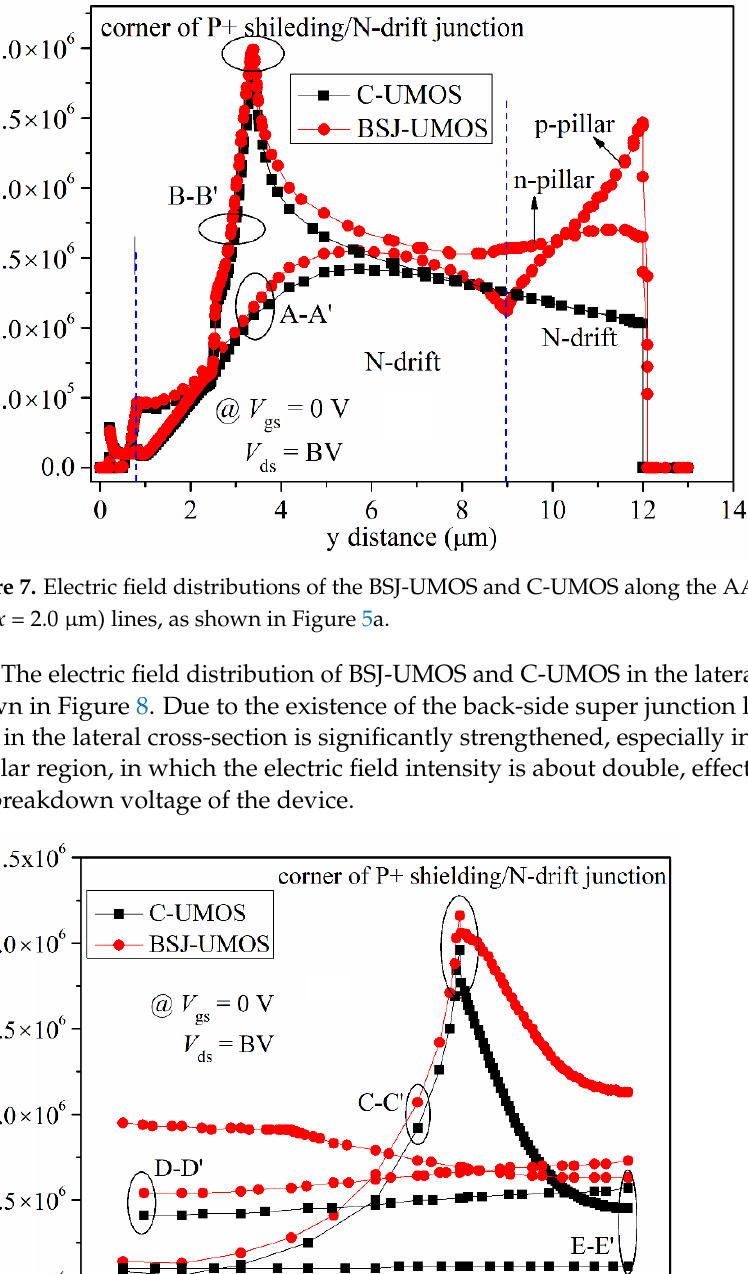
Figure 6. Electric field distributions at V gs = 0 V and V ds = BV in ( a ) C-UMOS and ( b ) BSJ-UMOS.